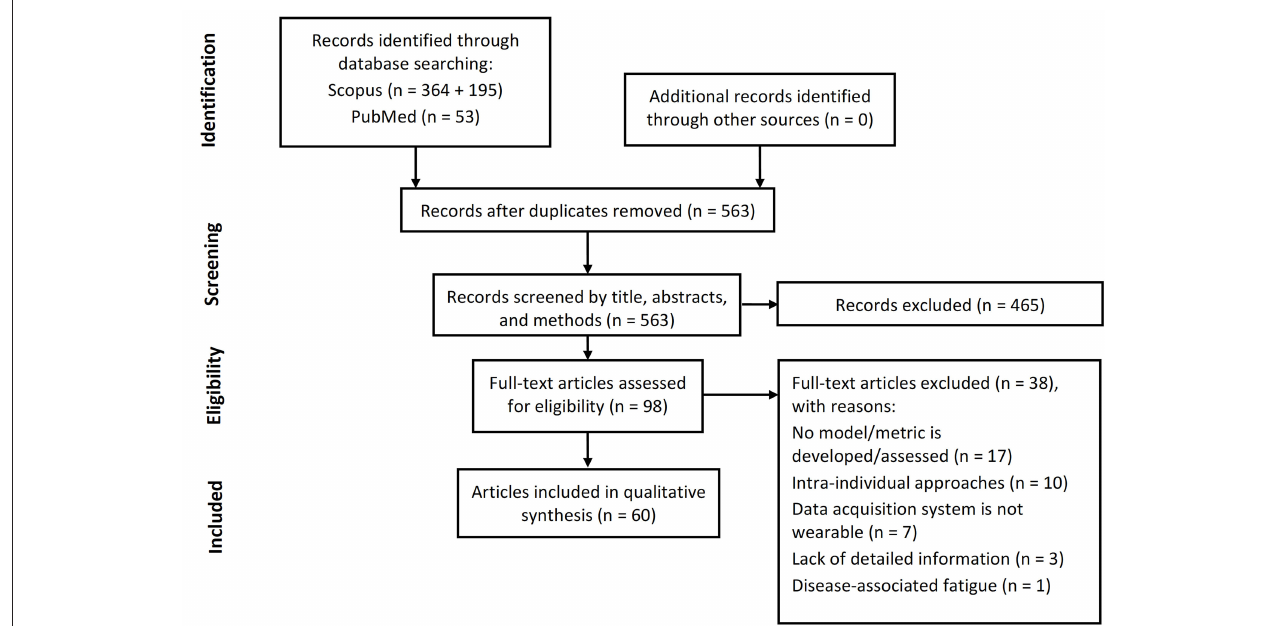
FIGURE 1 | PRISMA flowchart. Flow of information through the different phases of articles selection process.